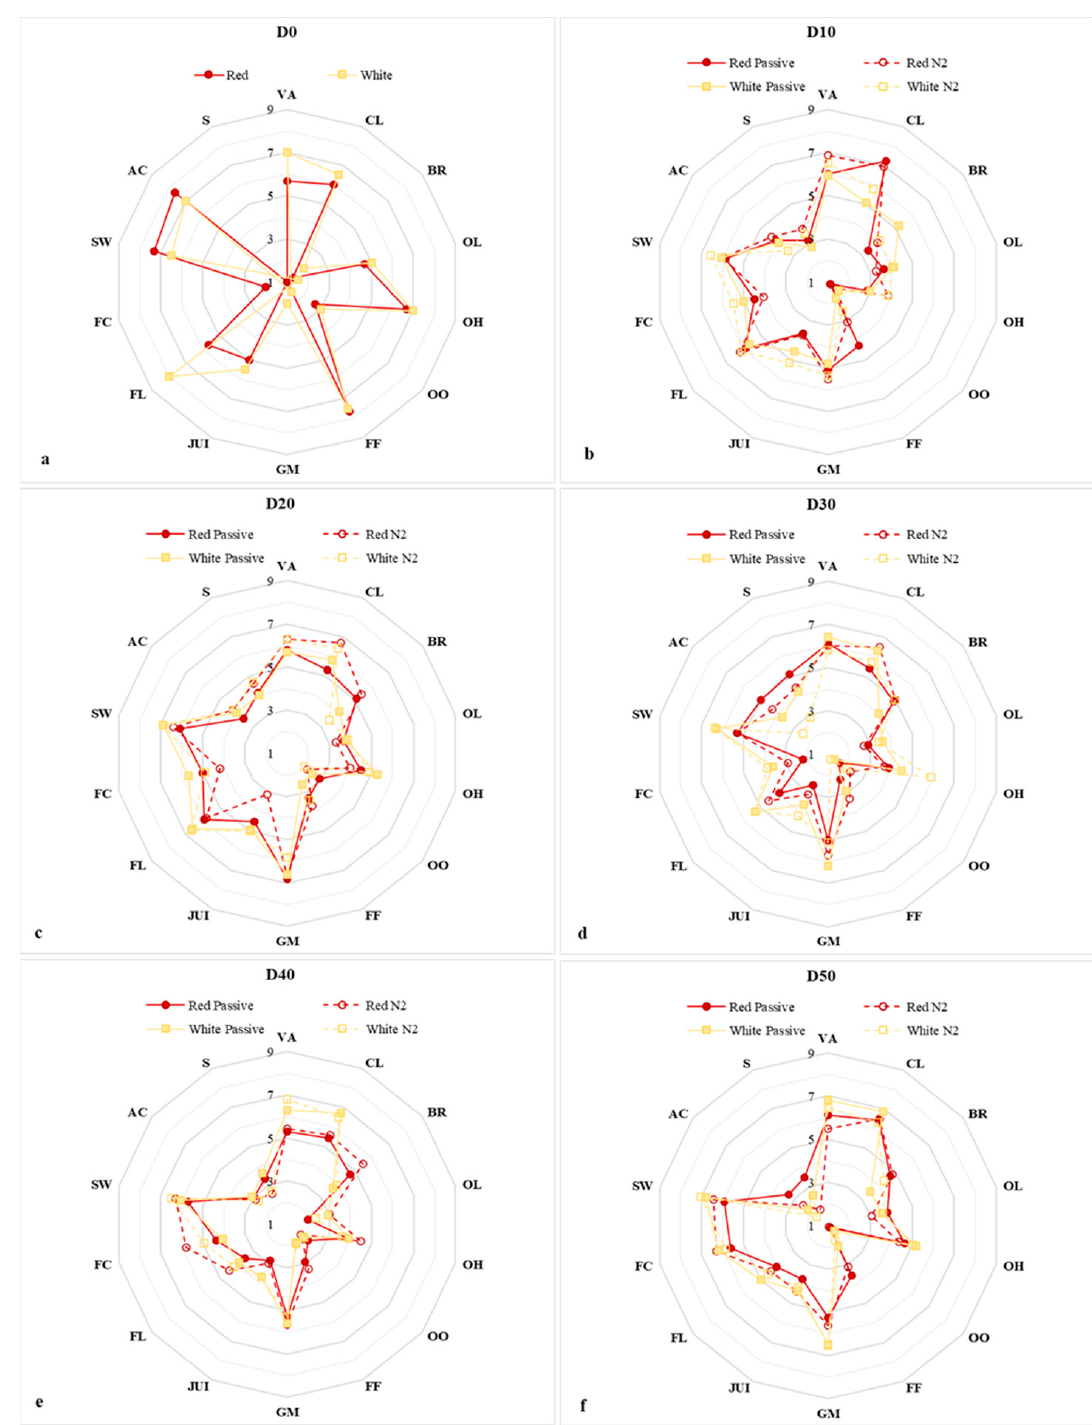
Figure 6. Results of the sensory analysis conducted on the dehydrated loquat slices at 0 ( a ), 10 ( b ), 20 ( c ), 30 ( d ), 40 ( e ), and 50 ( f ) days of storage. Legend: visual appearance (VA); color (CL); browning (BR); loquat odor (OL); honey odor (OH); off-odor (OO); crispness (FF); softness (GM); juiciness (JUI); loquat flavor (FL); caramel flavor (FC); sweetness (SW); acidity (AC); sourness (SO).